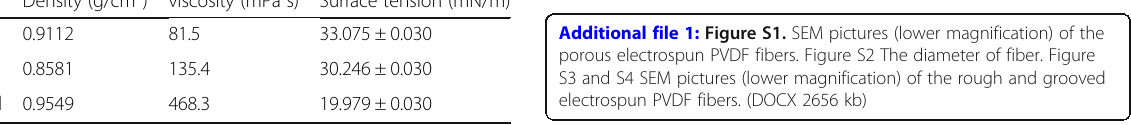
Table 2 The basic properties of the oils used in this work Oil